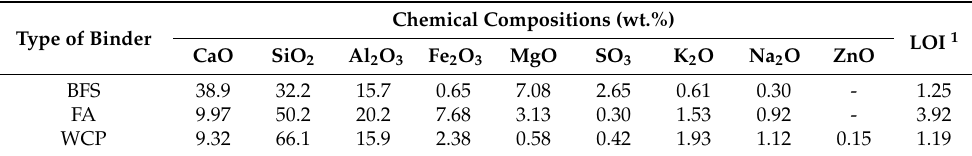
Table 1. Chemical properties of BFS, FA, and WCP used in this study.